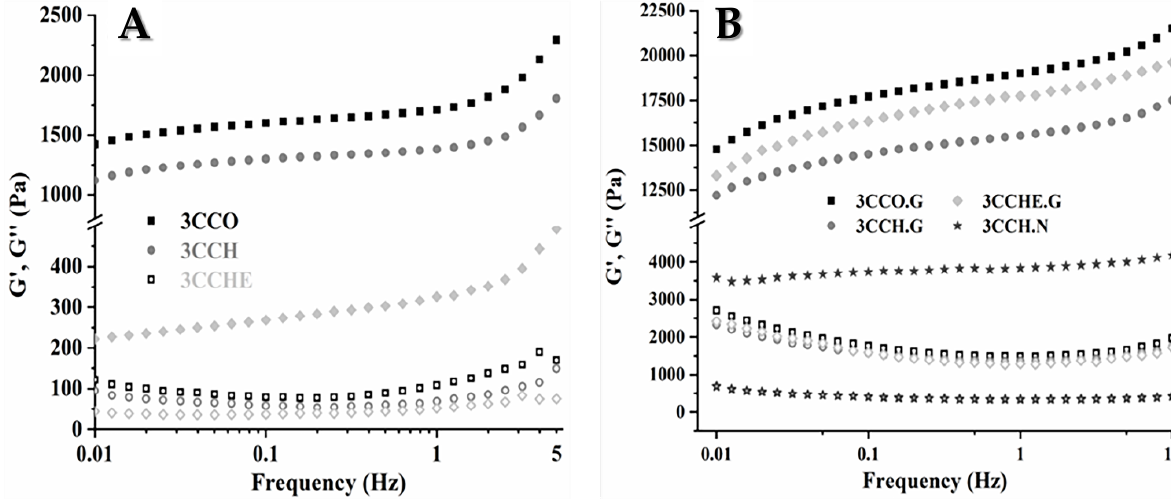
Figure 4. G’ (fill) and G” (open) moduli of physically ( A ) and chemically ( B ) crosslinked scaffolds. Each curve corresponds to the average of three different measured samples. Error bars have been omitted for clarity.